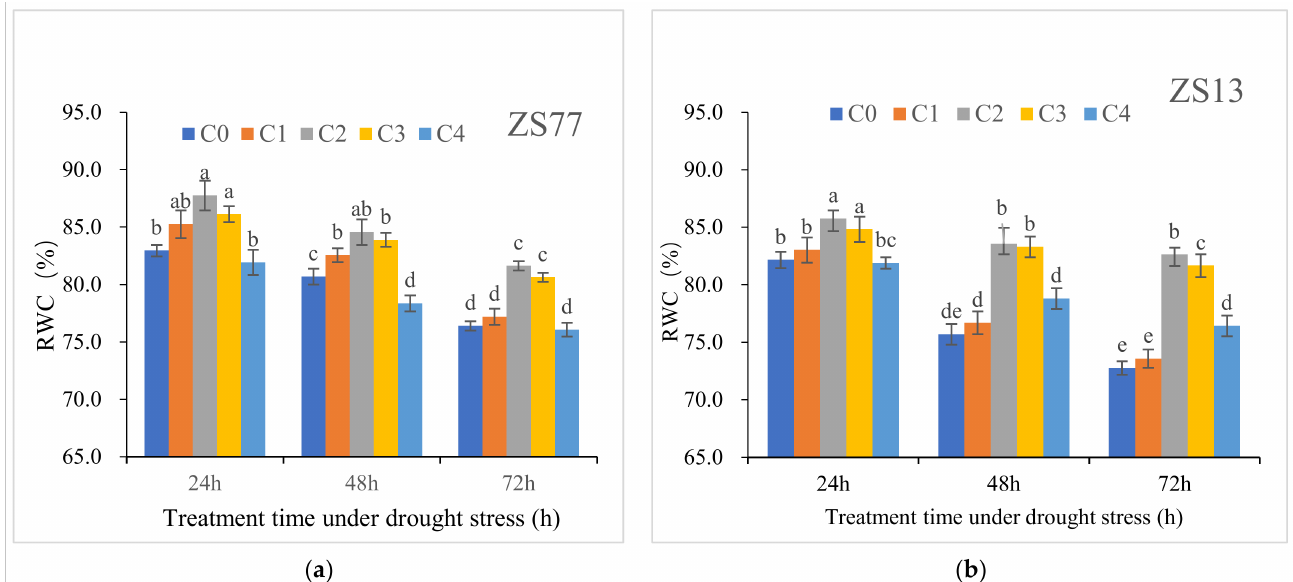
Figure 6. Effect of different concentrations of exogenous SA solution 0 (C0), 1.00 (C1), 2.00 (C2), 4.00 (C3), and 8.00 mg · L − 1 (C4) on RWC of sweet-potato leaves under drought stress. Bars with different letters indicate significant differences among treatments at 0.05 level